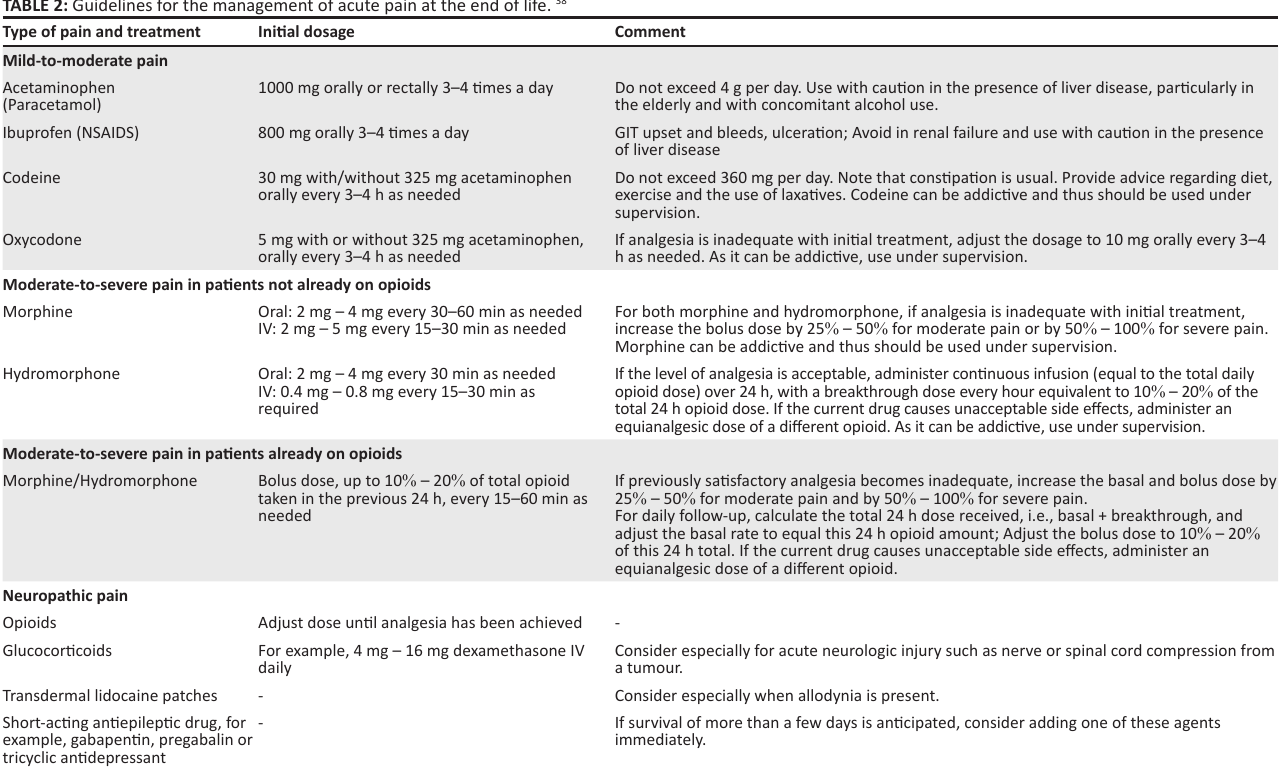
TABLE 2: Guidelines for the management of acute pain at the end of life.